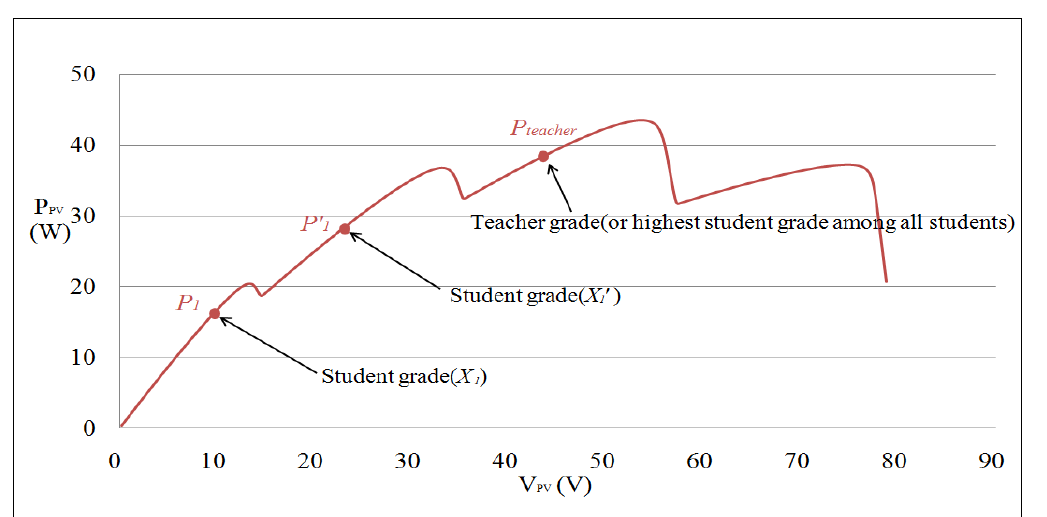
Figure 4. Adjustment of teaching factors of the proposed I-TLBO.